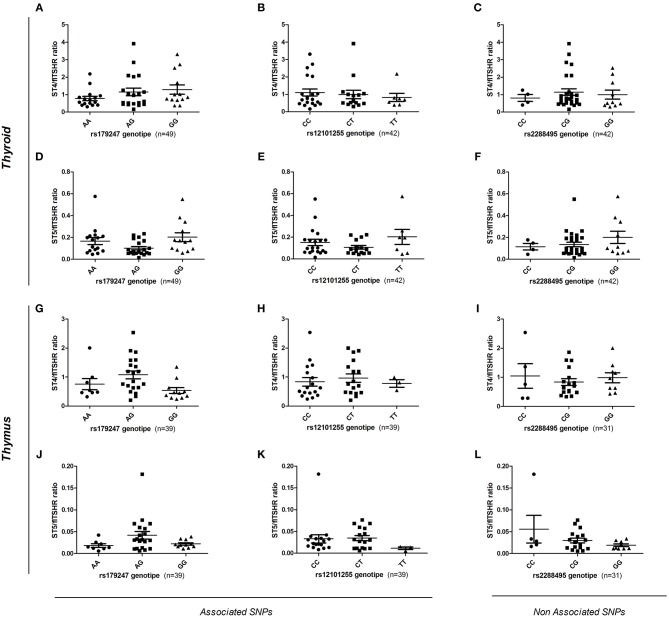
Effect of GD-associated SNPs (rs179247 and rs12101255) on the expression of TSHR alternatively spliced isoforms in human thyroid and thymus samples. The relative level of flTSHR, ST4, and ST5 expression was measured by qPCR and normalized to the level of GAPDH expression. The ratio of each short ST4 and ST5 transcript to the flTSHR was calculated for each individual and the data were grouped by SNP genotype. (A–F) The relative ST4 and ST5 expression in the thyroid is presented. (G–L) Relative level of ST4 and ST5 expression in the thymus is presented. A non-GD-associated SNP (rs2288495) was also included as a control. Each point represents the mean value of triplicate results from one sample. The mean ± SEM of each group is shown. A Kruskal-Wallis with Dunn's multiple comparison test was used.